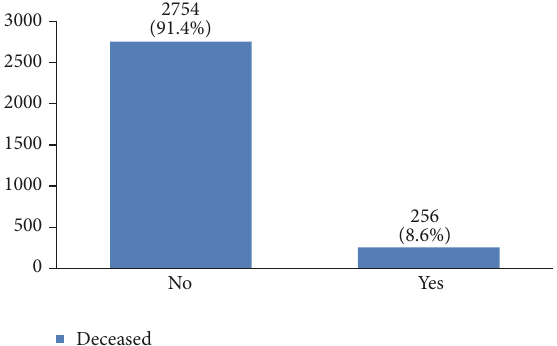
Figure 35: The percentage of the deceased because of breast cancer in the studied cases.